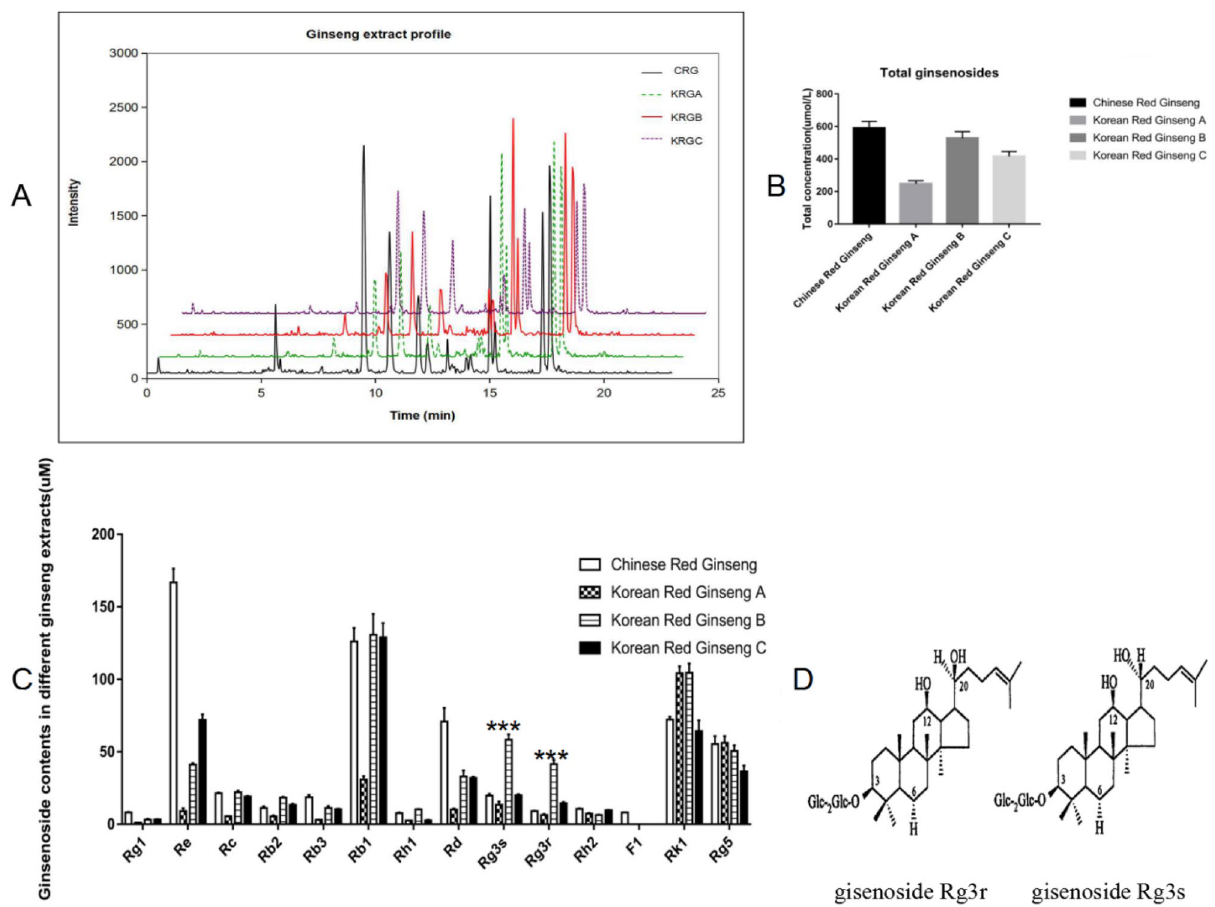
Figure 2. Levels of ginsenosides in the various red ginseng extracts. ( A ) UPLC ‒ MS/MS chromatogram of four red ginseng extracts. ( B ) Estimation of total ginsenosides in the indicated extracts. ( C ) Detection of individual ginsenosides in the indicated extracts. ( D ) Structures of the ginsenosides G-Rg3r and G-Rg3s stereoisomers. The data is presented as the mean ± SD of triplicate assays. *** P <